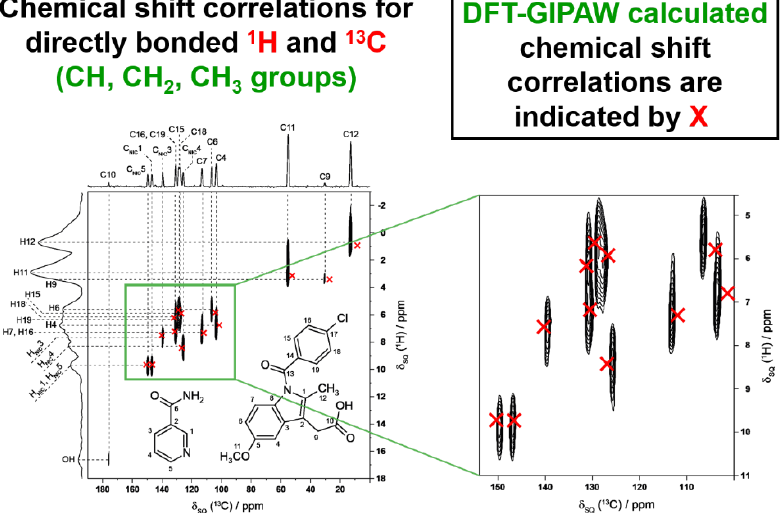
Figure 9. DFT – GIPAW calculated 1 H and 13 C chemical shift correlations (indicated by red crosses) for directly bonded CH, CH 2 and CH 3 moieties in the crystal structure of the indomethacin-nicotinamide co-crystal overlaid on the experimental 1 H – 13 C correlation NMR spectrum. The green box highlights the region of the spectrum corresponding to the aromatic CH resonances.